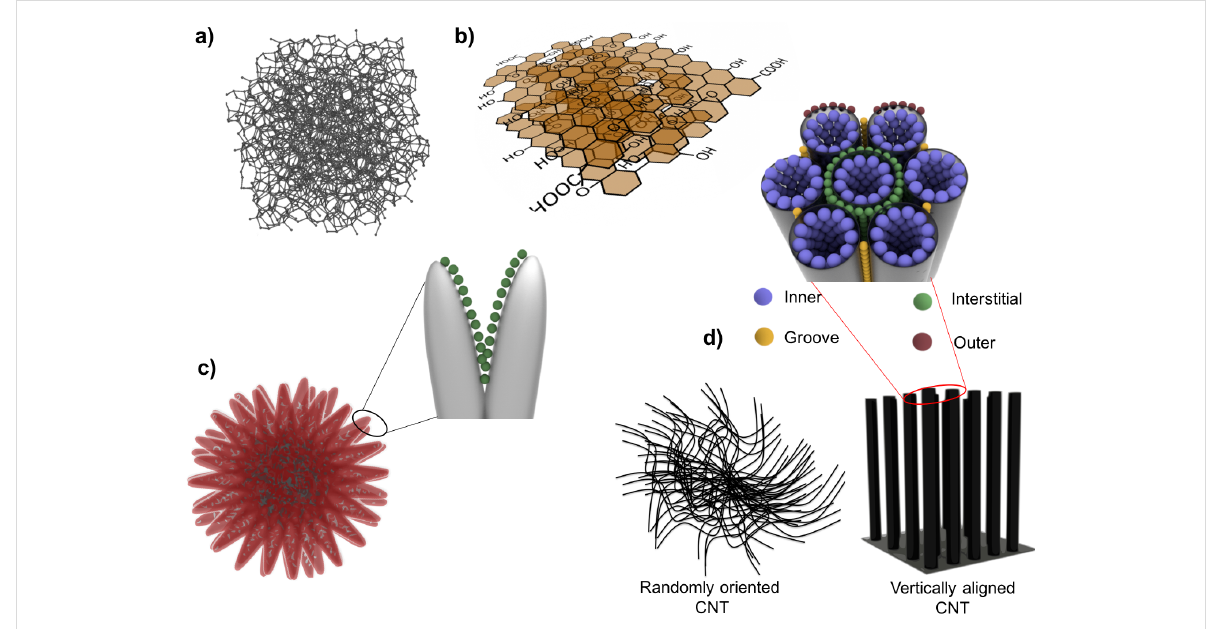
Figure 1: Schematic of different adsorbents: a) activated carbon, b) graphene oxide, GO (for the ease of presentation the carbon skeleton in b) is drawn in a planar fashion; however, there is noticeable deviation from planarity in GO); c) carbon nanohorns, d) carbon